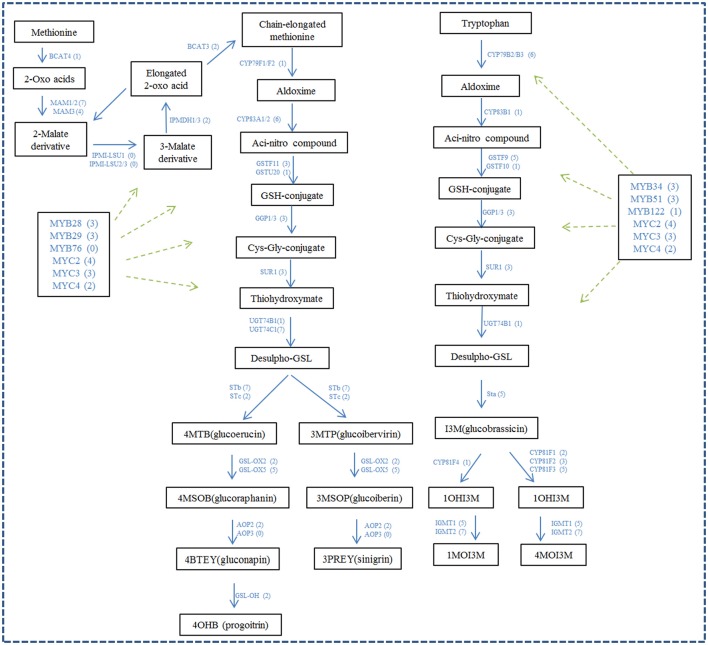
The unigenes likely involved in glucosinolates biosynthesis and its regulation. The figure is adapted from Sønderby et al. (2010), Yatusevich et al. (2010), Schweizer et al. (2013), and Liu et al. (2014). The numbers in brackets following each gene name indicate the number of unigenes annotated to that gene.